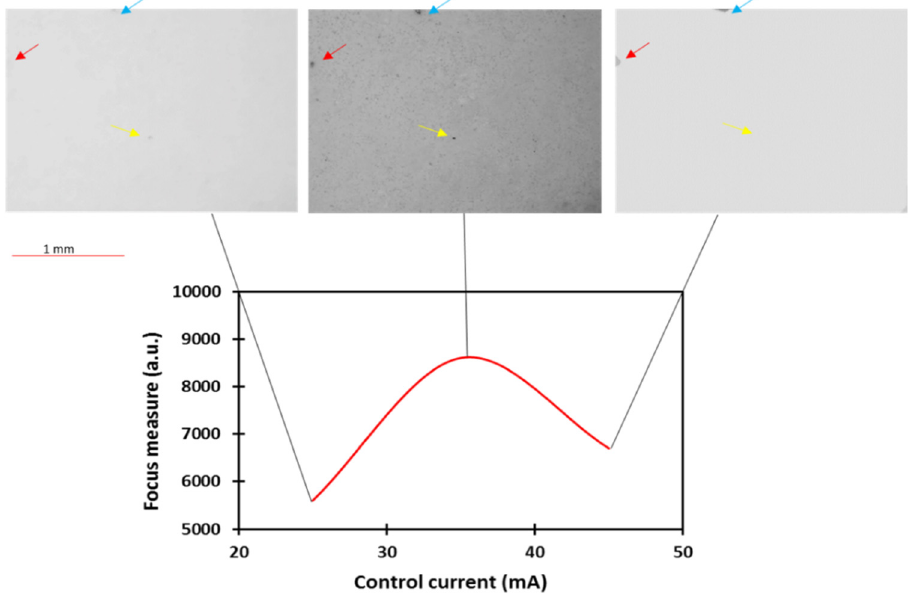
Figure 4. Gaussian-like curve illustrating the autofocusing ability of the system by presenting the images captured at the peak and the extreme ends of the curve.